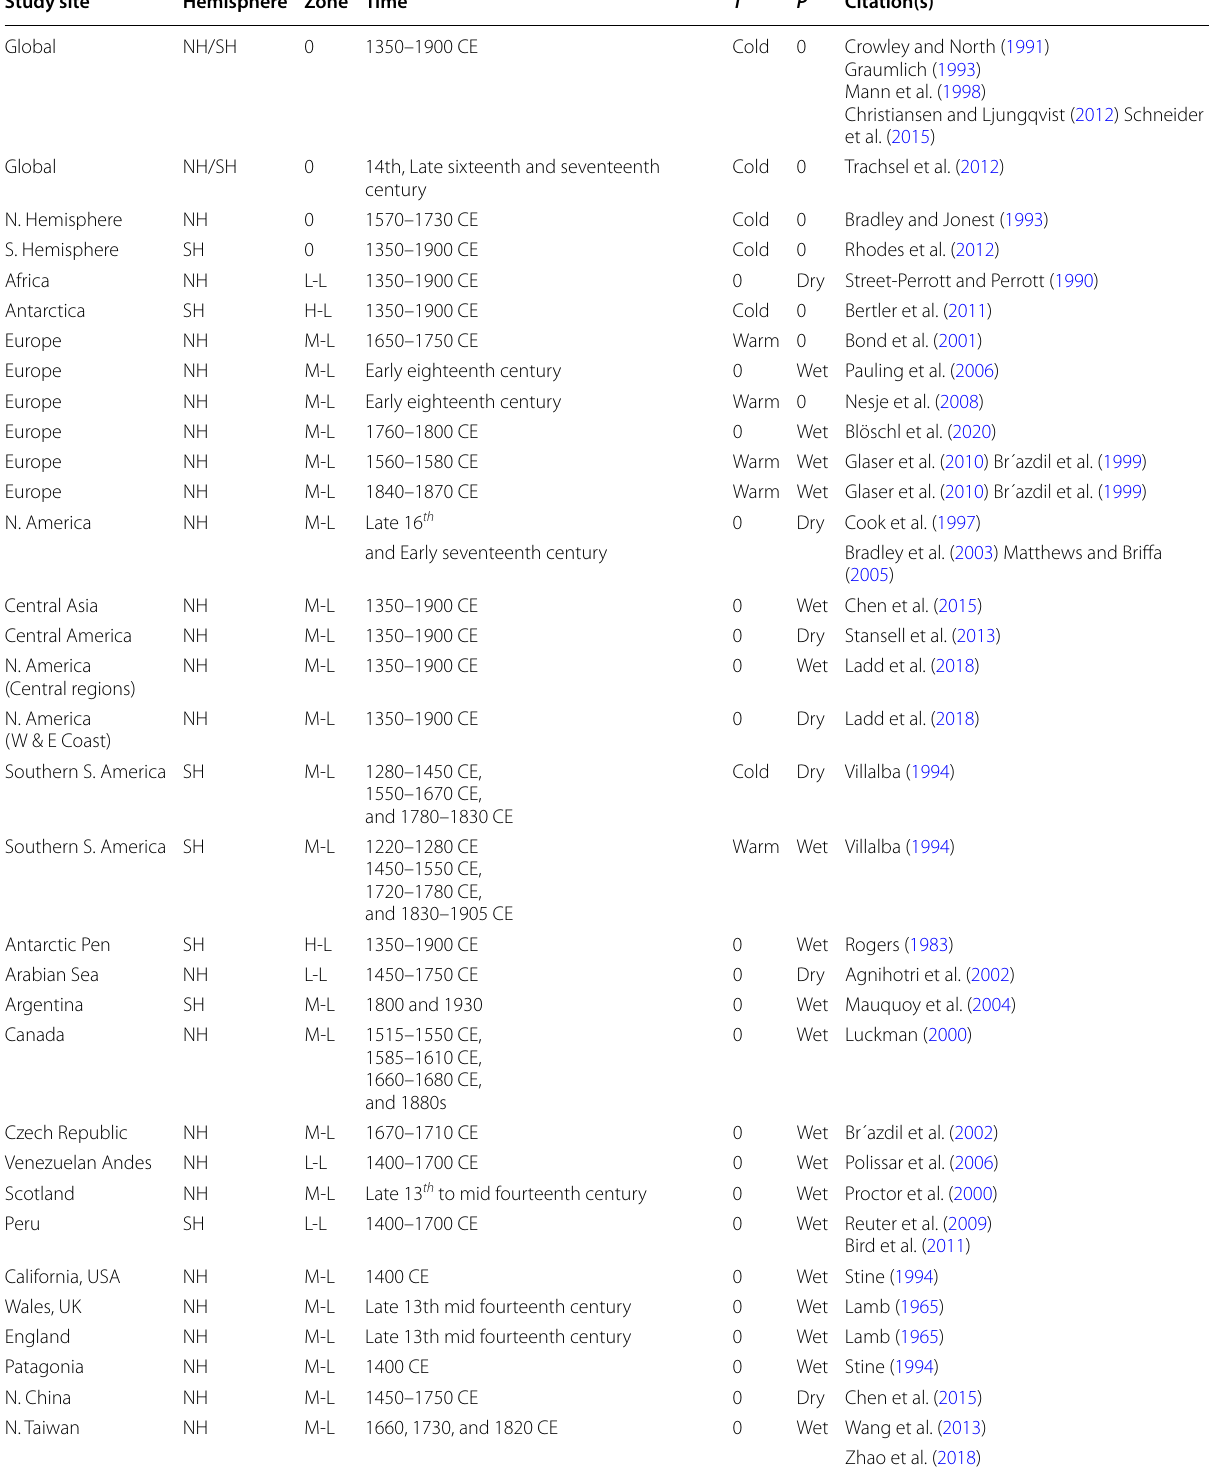
Table 9 Temperature and precipitation conditions during the